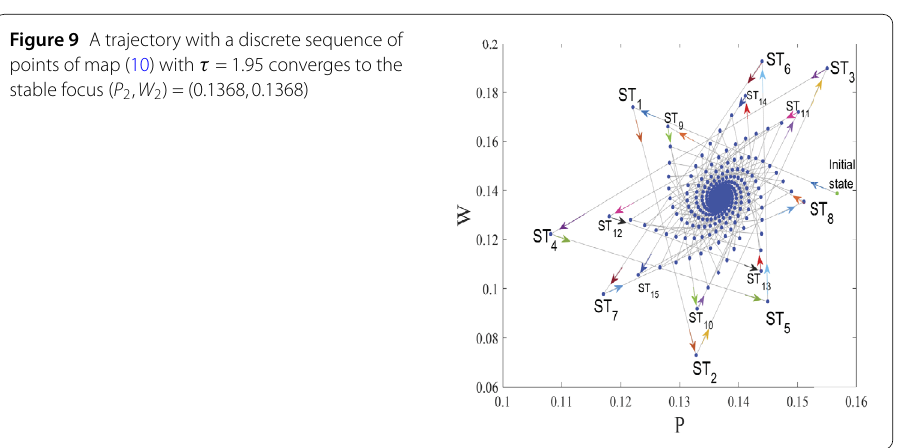
Figure 9 A trajectory with a discrete sequence of points of map (10) with τ = 1.95 converges to the stable focus ( P 2 , W 2 ) =